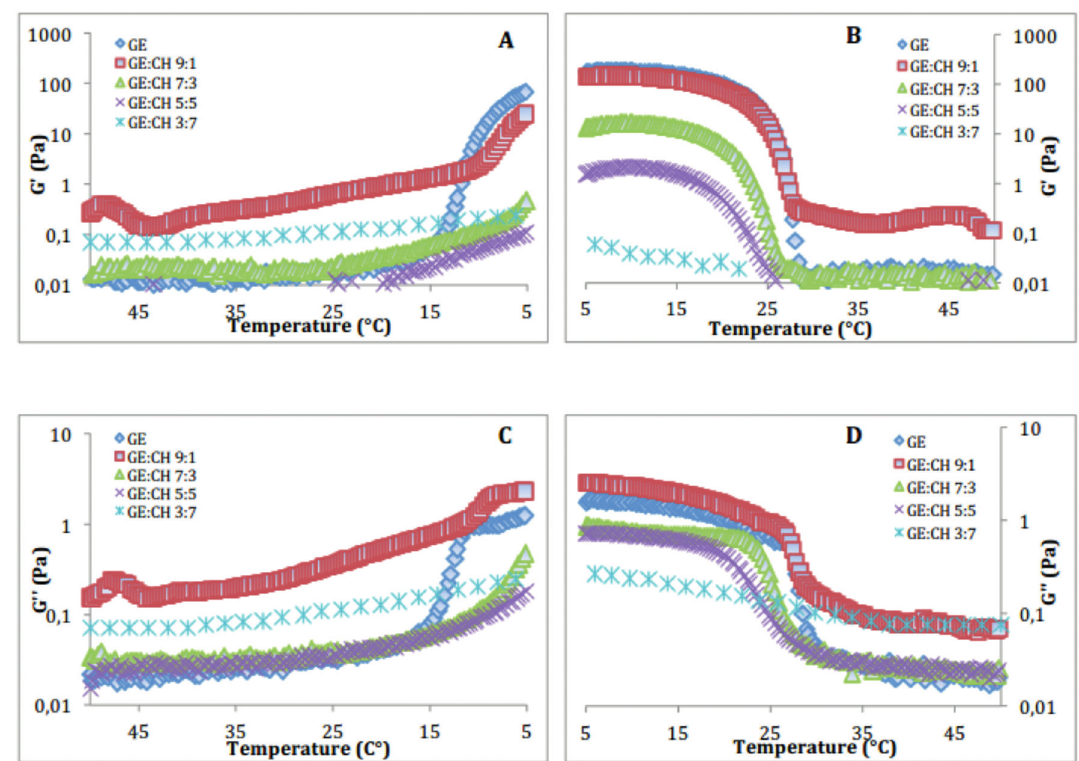
Figure 2: Storage (G’) and loss (G’’) moduli of scaffold based on blends of gelatin and chitosan as a function of temperature. (A and C) cooling; (B and D) heating, both at